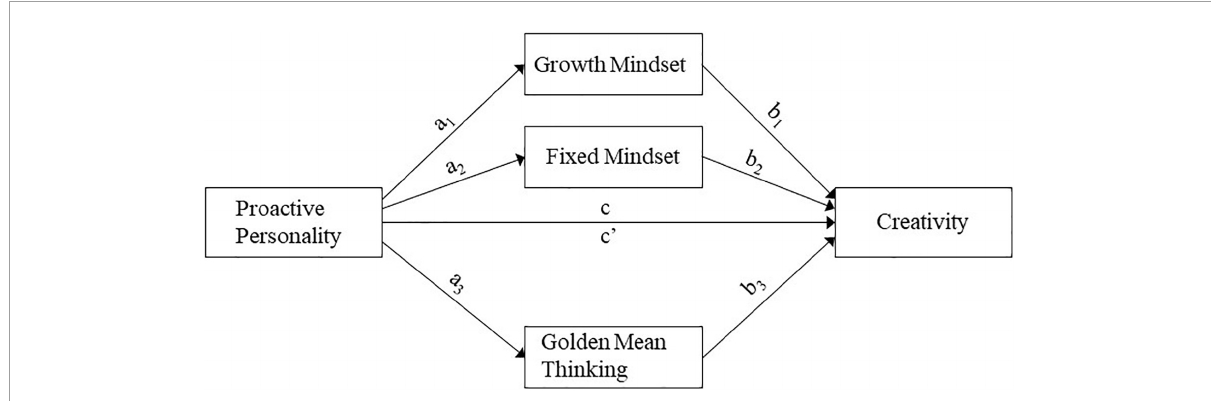
FIGURE1 Conceptual mediation model of the mediating effects of growth mindset, fixed mindset, and golden mean thinking in the relationship between proactive personality and